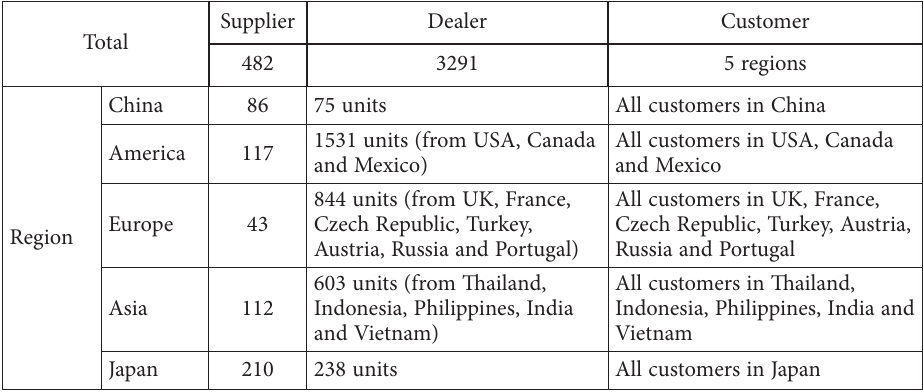
Table 4. Supplier and Dealer statistics (source: authors’ own